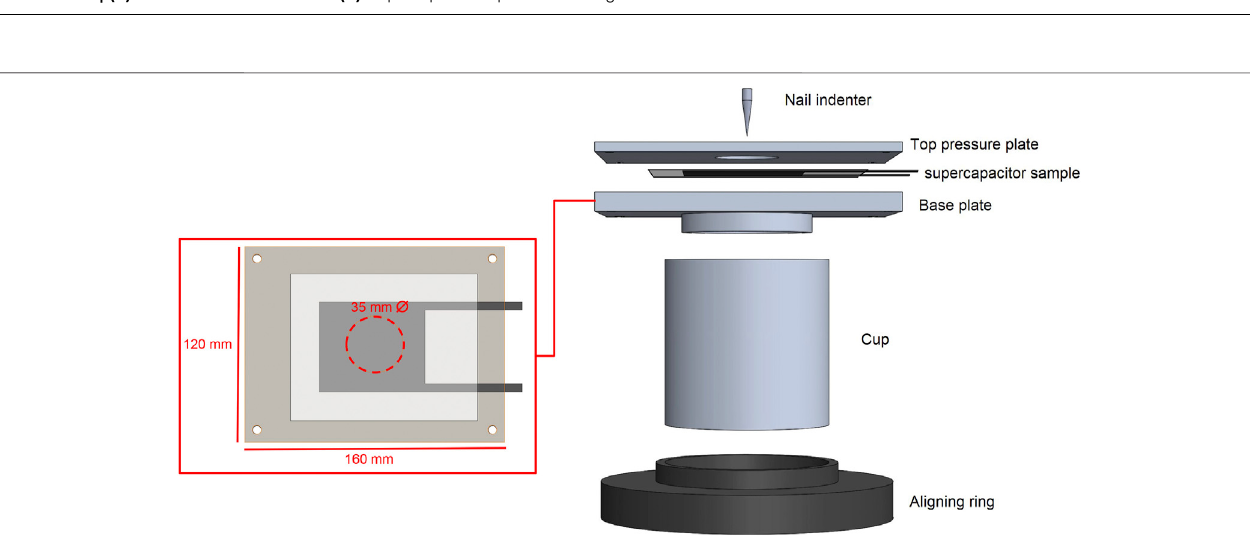
FIGURE 2 | Base plate dimensions and the effective area of unsupported specimen and CAD model of the bespoke nail penetration test rig.